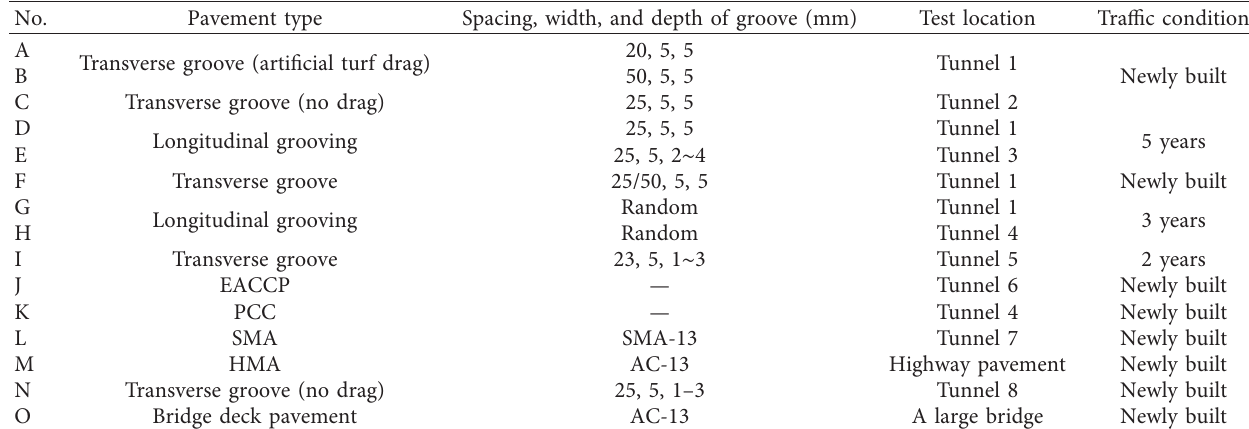
Table 1: Details of testing concrete